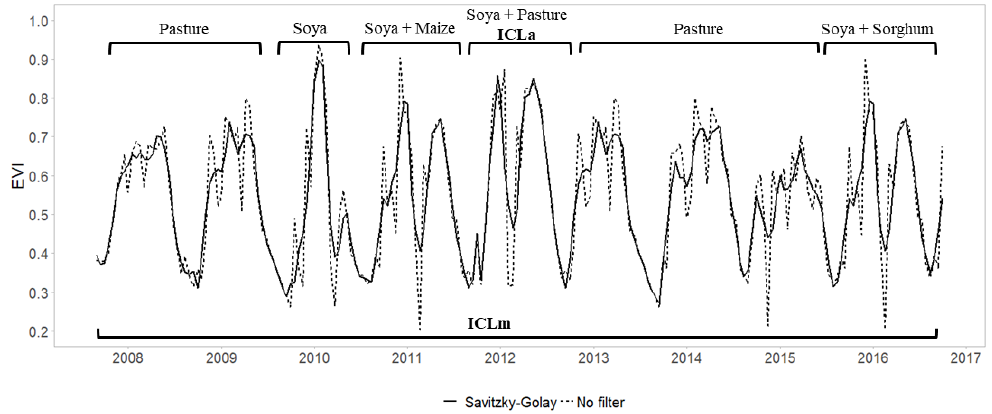
Figure 2. Examples of annual integrated crop-livestock (ICLa) and multi-annual integrated crop- livestock (ICLm) Enhanced Vegetation Index (EVI) temporal behavior, non-filtered, and filtered by